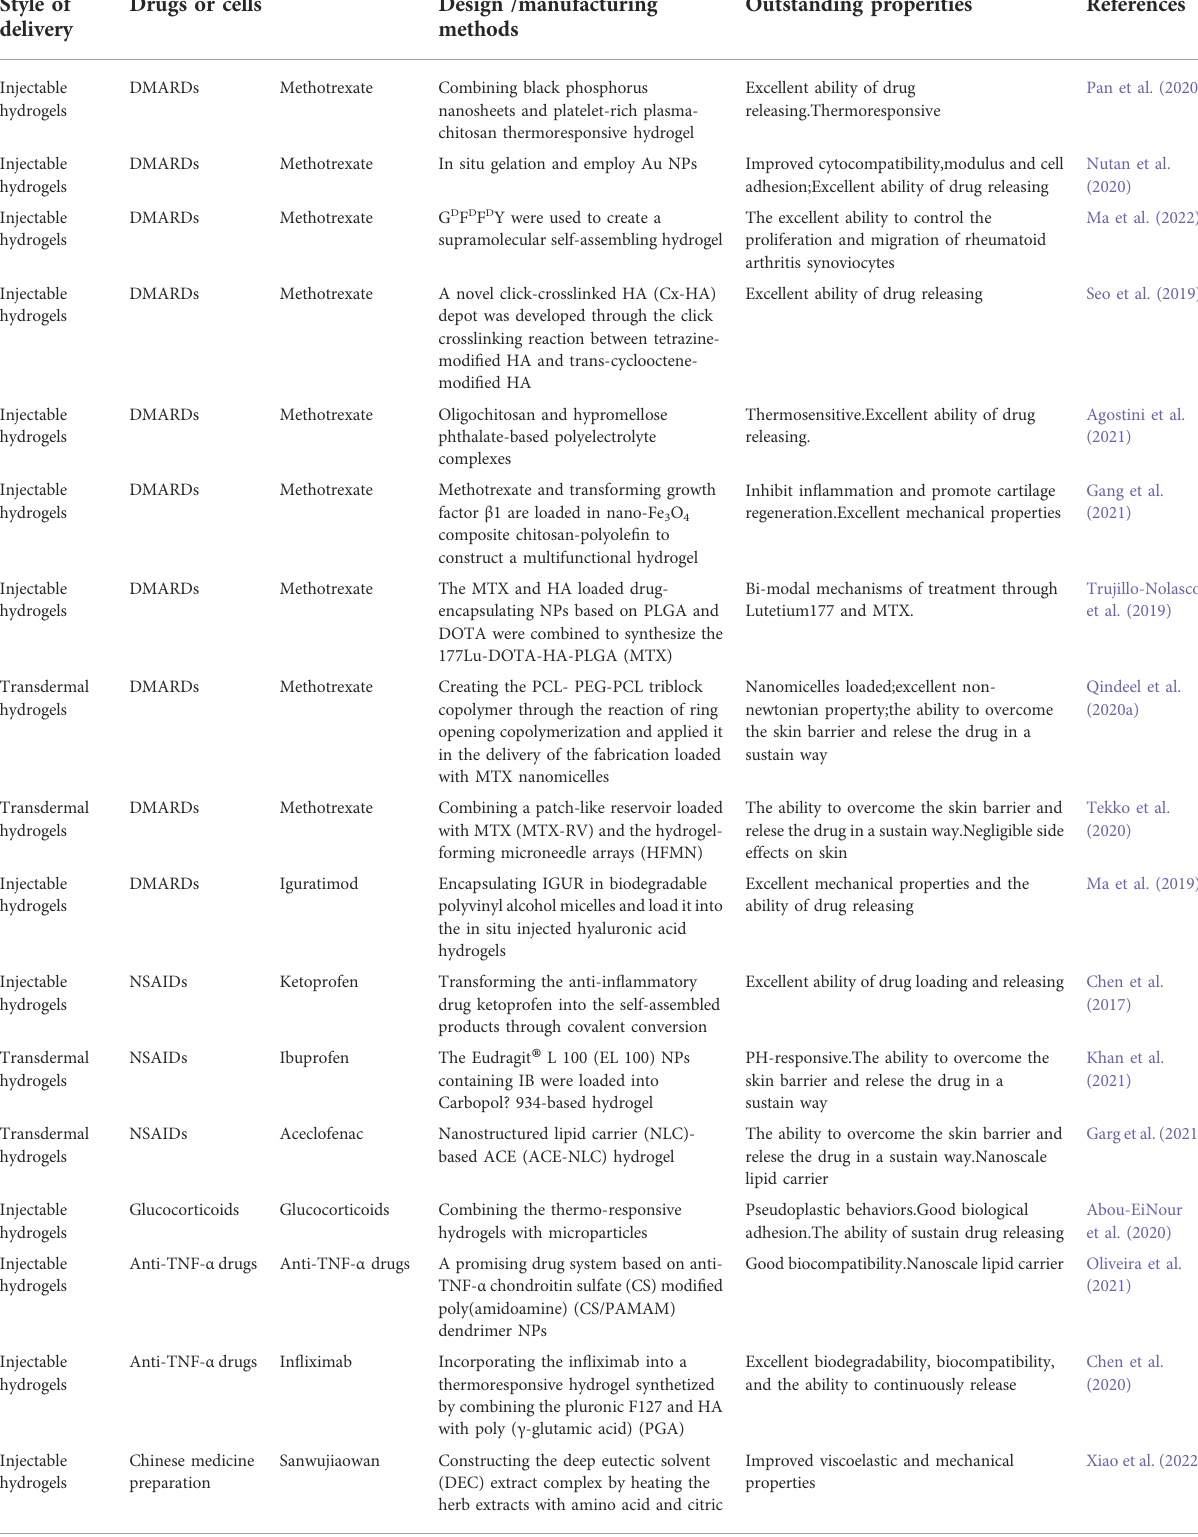
TABLE 1 The outline table of hydrogels applied in the treatment of rheumatoid